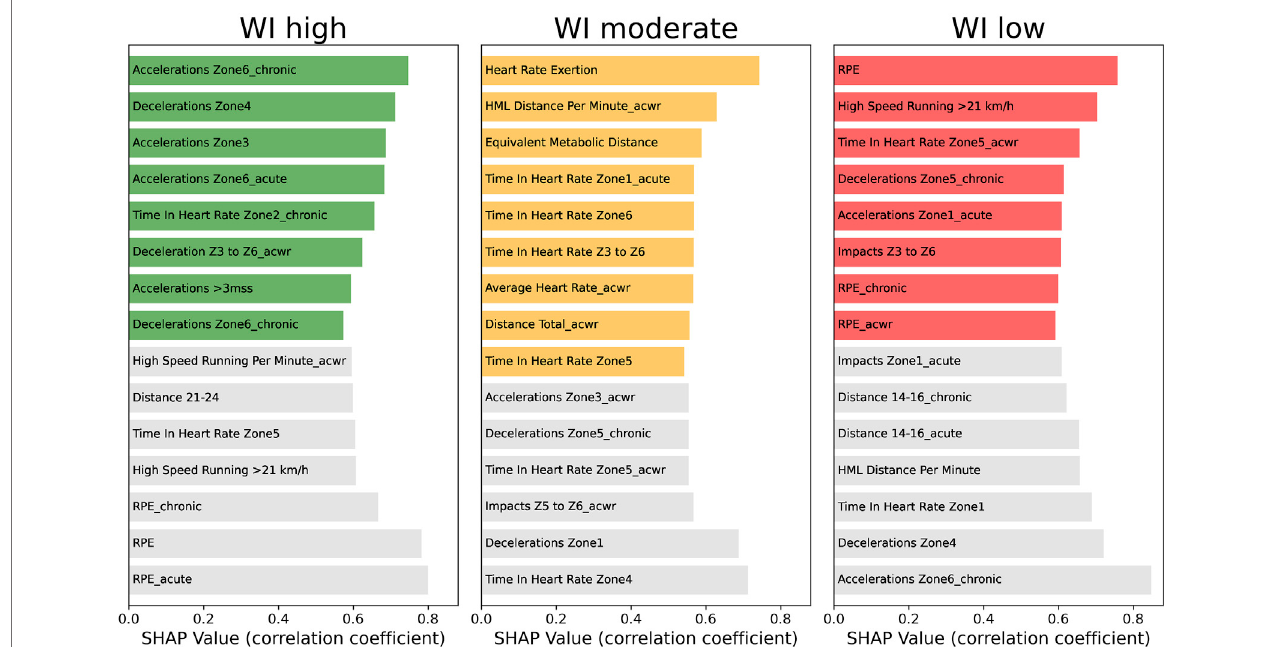
FIGURE 3 | In fl uence of the 15 most important features of each WI class on de fi ning classes ’ membership. This plot shows the correlation coef fi cient between SHAP values and features ’ values. Coloured bars refer to a positive correlation, while the grey ones show a negative relationship.